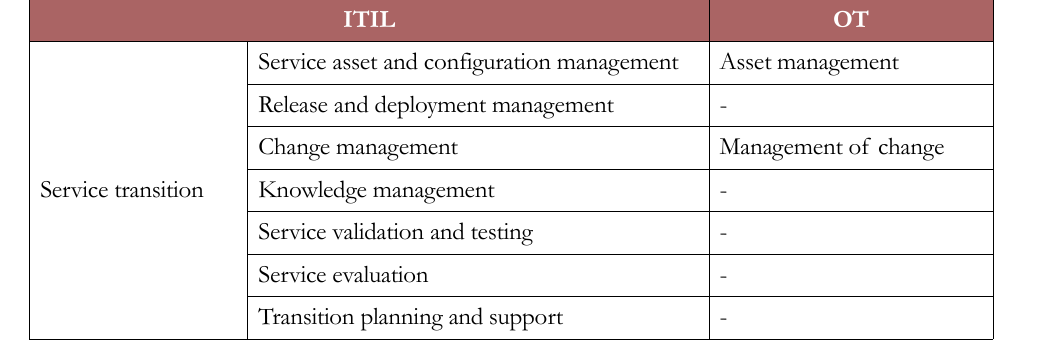
Table 5. High-level service transition ITIL - OT